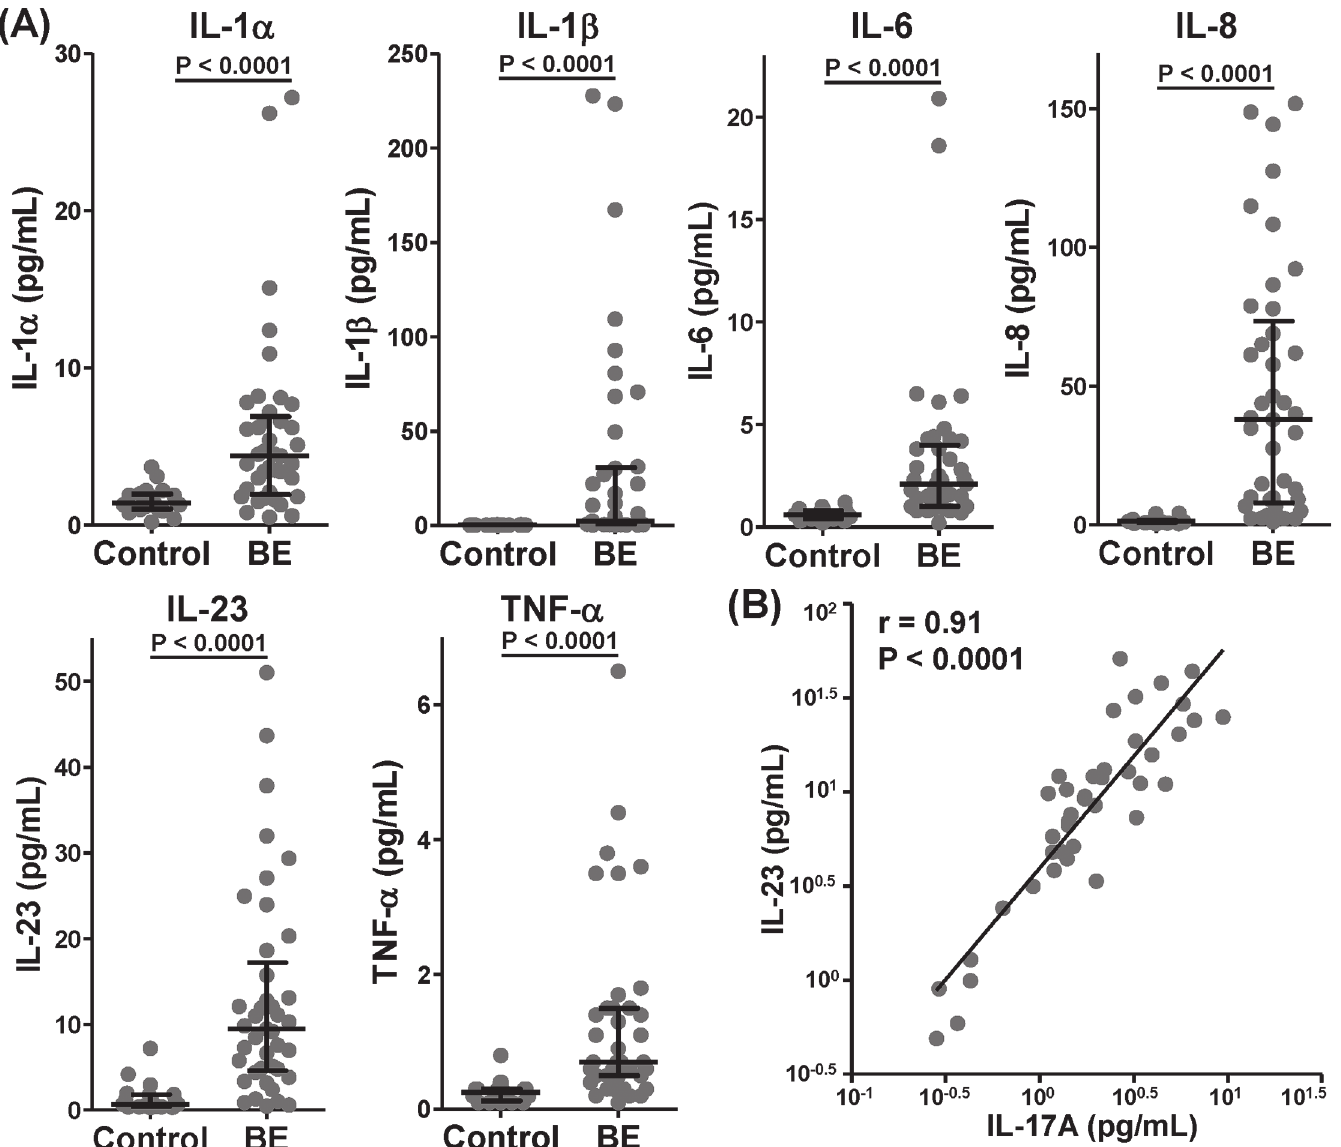
Fig 2. Bronchoalveolar lavage fluid levels of Th17 pathway cytokines and chemokines are significantly increased in adult non-CF bronchiectasis. (A) All Th17 pathway mediators are significantly increased in non-CF bronchiectasis (n = 41) compared with healthy control (n = 20) subjects. (B) Bronchoalveolar lavage fluid levels of IL-17A correlate strongly with all Th17 pathway mediators, but most strongly with IL-23 (n = 61). (Cont — control, BE — bronchiectasis; Box and whisker plots display median and interquartile ranges; p values are by Mann-Whitney U test).